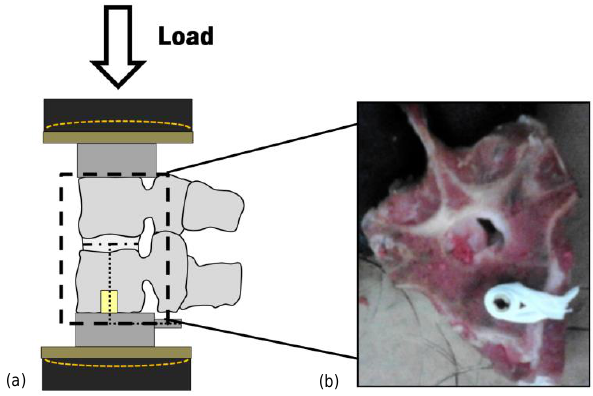
Figure 3. Motion segment attachment. (a) The MS was placed be- tween two plates of Instron ® 8874, being subjected to compres- sion. The bottom plate is drilled, allowing the fluid passage from pressure apparatus to the hollowed screw. The attachment is done on epoxy resin (yellow region), to provide a better adhesion of the screw; (b) top vision of a drilled MS, with the presence of the self- tapping screw on the vertebral